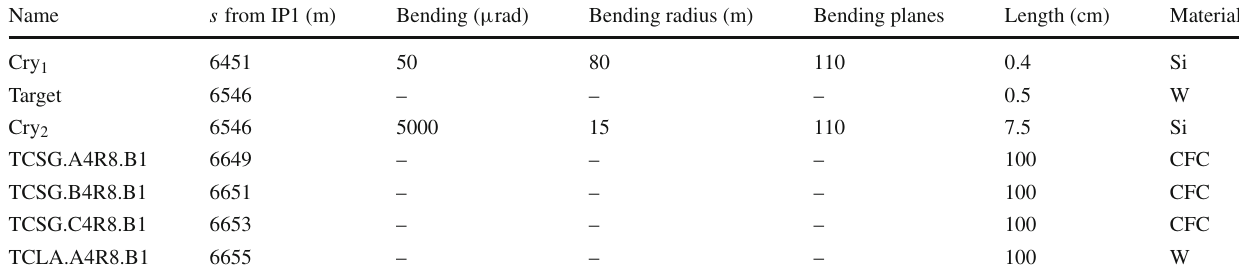
Table 2 Installation position and main features of the proposed experimental layout in IR3. All the components act on the vertical